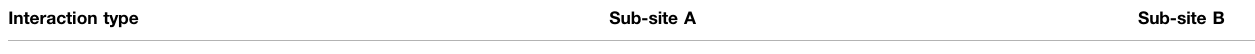
TABLE 4 | Criteria for the fi ltering of the docked 31,555 molecules from the ISE model. Interaction